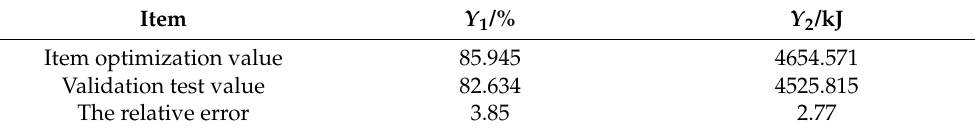
Table 4. Comparison between model optimization value and validation test